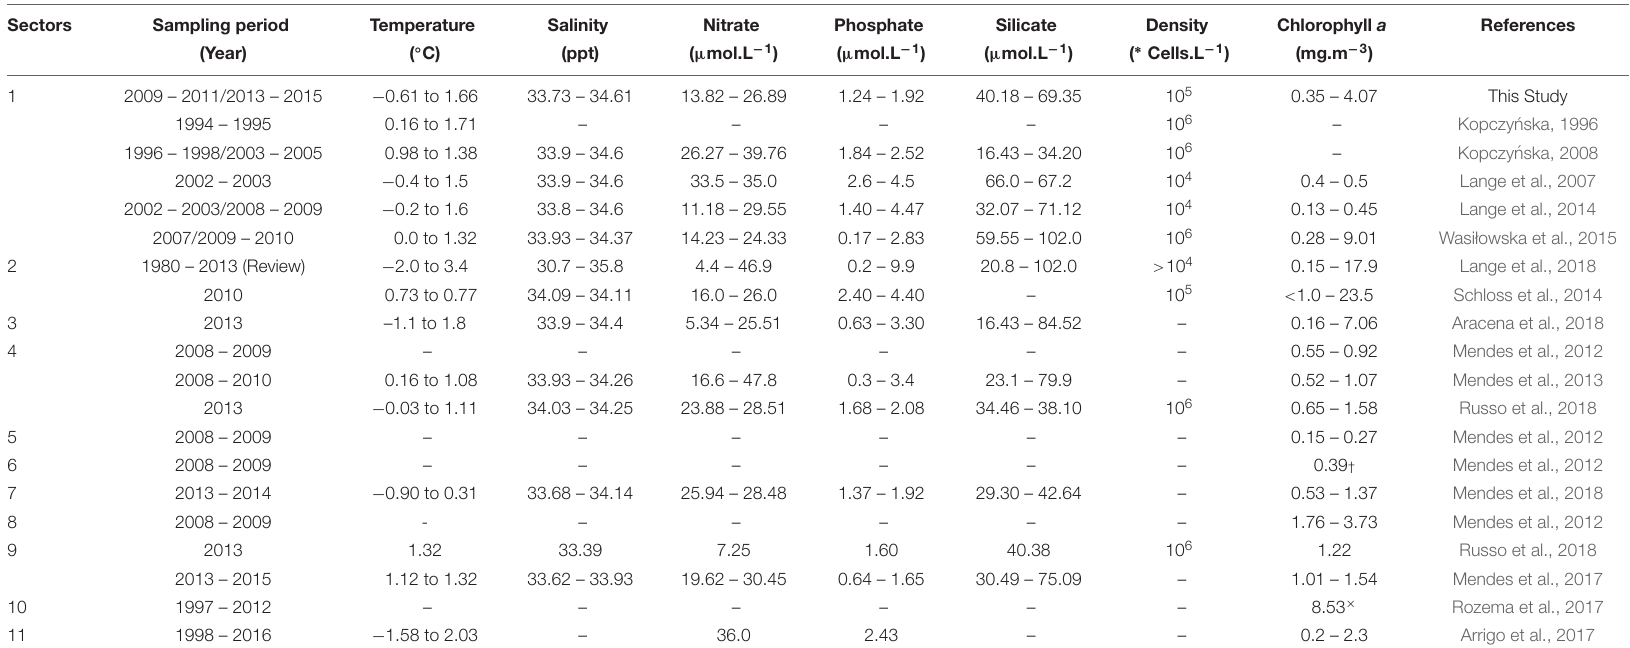
TABLE 3 | WAP Subdivision for comparison with Admiralty Bay local environmental